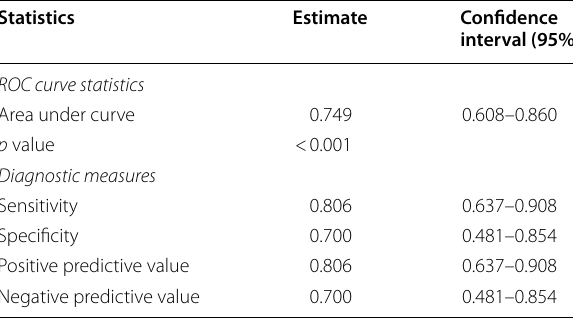
Table 3 ROC curve results and statistical diagnostic measures for cfRNA 1 for determining Endometrial ≥